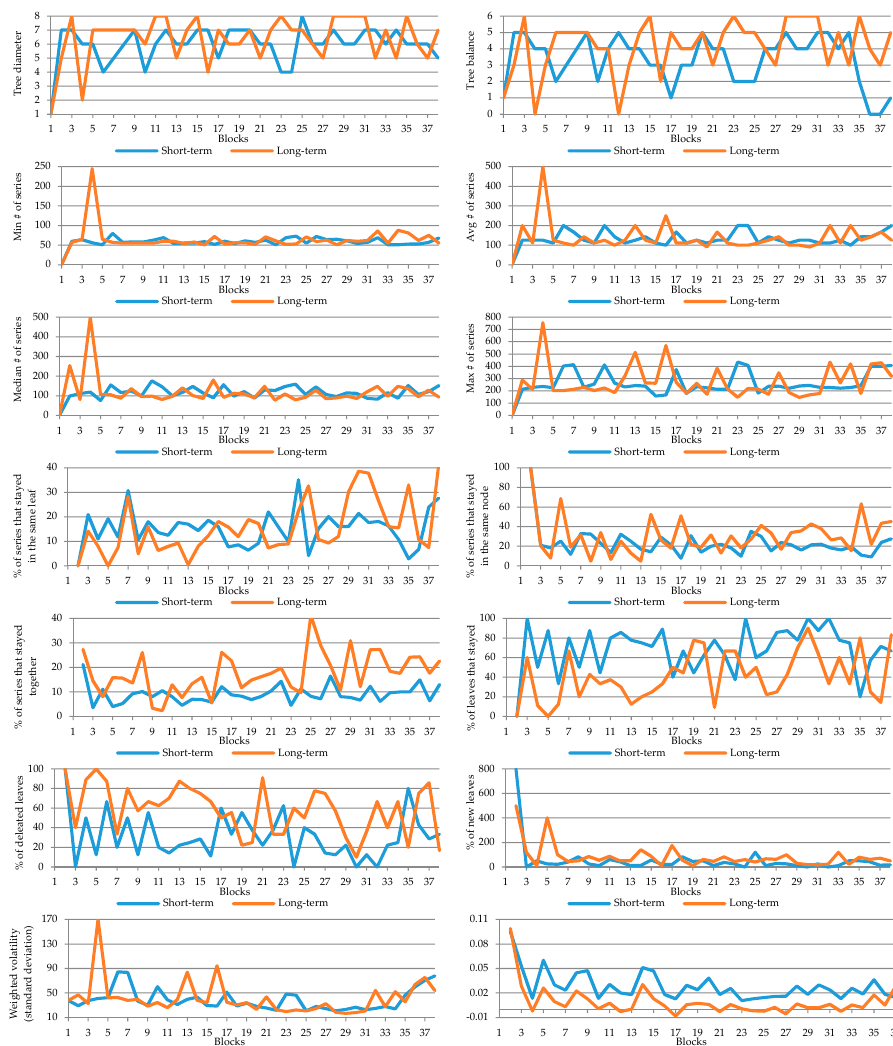
Figure A2. Detailed results for 𝑚𝑖𝑛𝑆𝑒𝑟𝑖𝑒𝑠 set at 5% and window length 𝑤 set at 14 days .